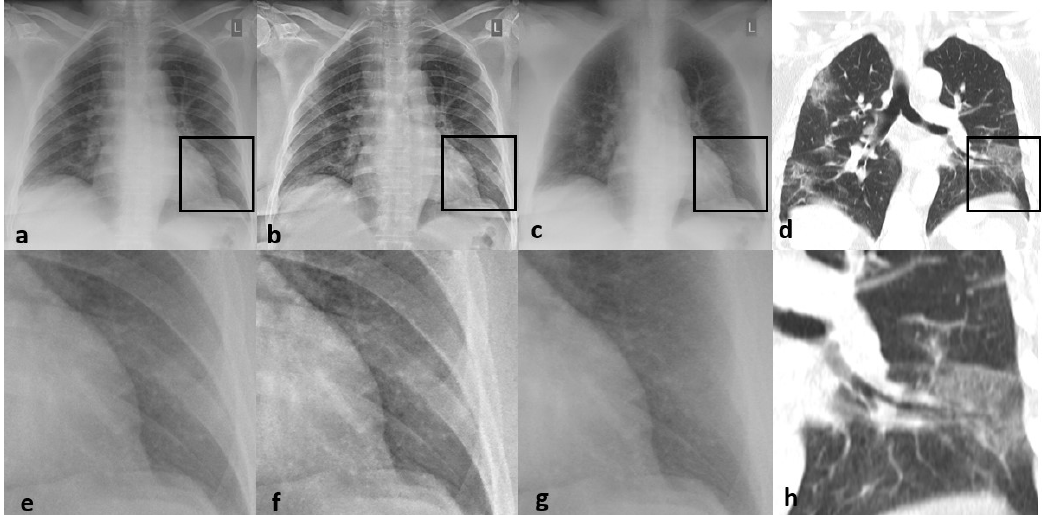
Figure 2. 53-year-old male patient with rt-PCR proven COVID-19 pneumonia symptomatic since 6 days with fever and cough showing typical lung changes of COVID-19 pneumonia on ( d , h ) CT with wedge-shaped subpleural ground-glass opacification (GGO). These changes are hidden by the ribs in the ( a , e ) conventional radiograph (CRX), slightly visible on the ( b , f ) enhanced CRX, and better visible on the ( c , g ) enhanced CRX with bone suppression. Table 2. Imaging findings.